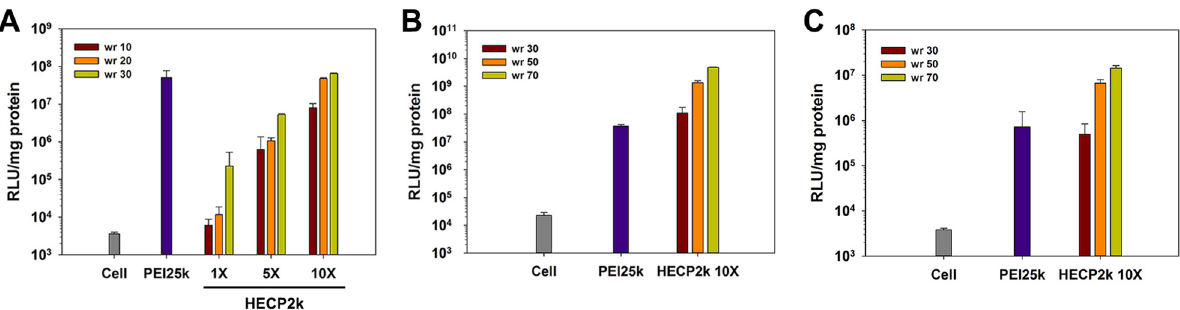
Figure 4. ( A ) Luciferase assay results of HECP2k polyplexes in HeLa cells at the various weight ratios (weight ratio, wr = 10, 20, or 30). Luciferase assay results of HECP2k 10X polyplexes in HeLa cells at the various weight ratios in ( B ) serum-free conditions and ( C ) serum conditions. PEI25k polyplexes (wr = 1) were used as control.